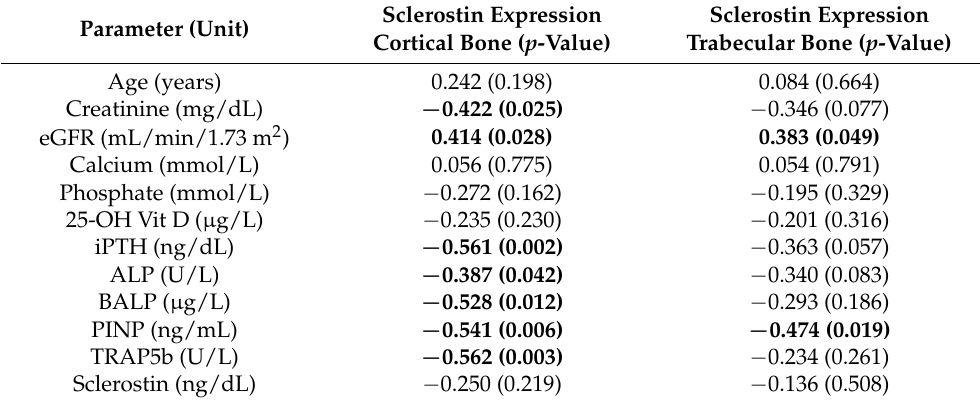
Table 5. Bone sclerostin expression, serum biochemistry and circulating markers of bone turnover. Parameter